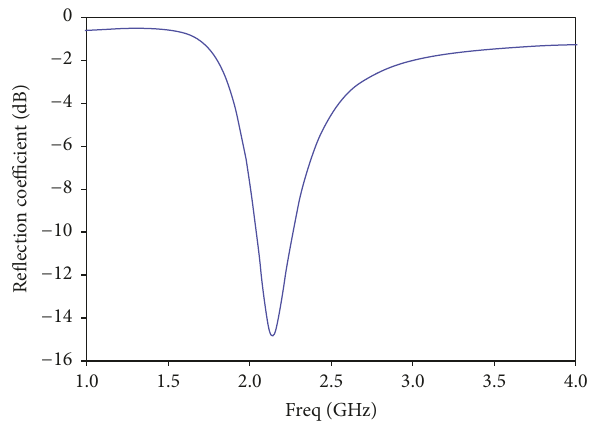
Figure 4: Slot resonance frequency without DRA.